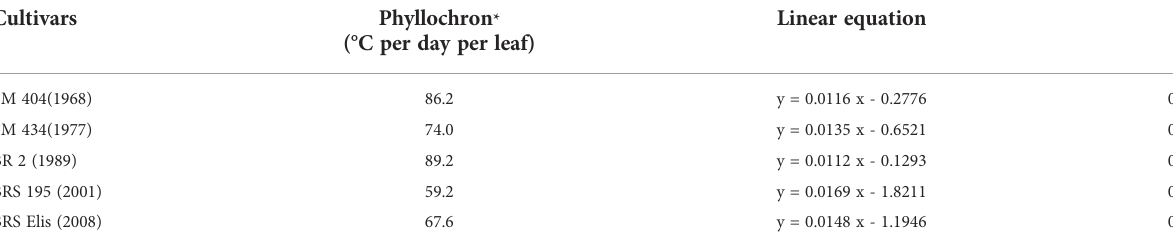
TABLE 4 Phyllochron for fi ve barley cultivars released at different eras in Brazil (FM 404; FM434, BR 2; BRS 195 and BRS Elis). Cultivars